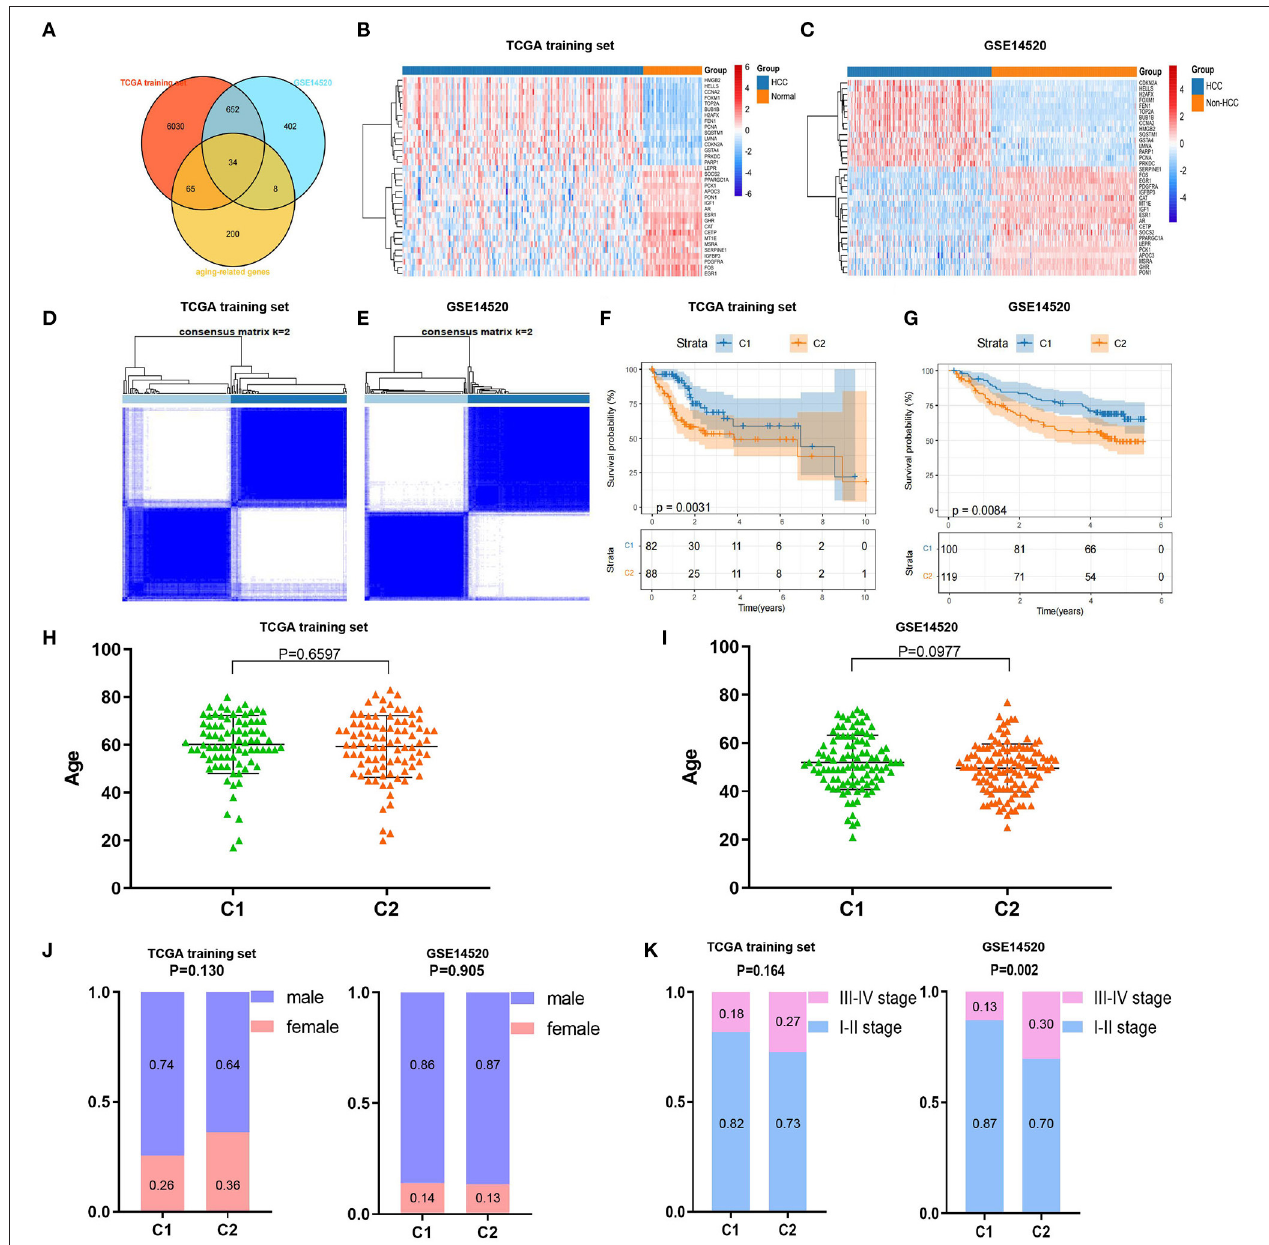
FIGURE 2 | Screening of differentially expressed aging-related genes (DEAGs), consistent clustering analysis, and comparison of molecular subtypes. (A) Venn diagram of DEGs from the The Cancer Genome Atlas (TCGA) training set, DEGs from GSE14520 and AGs. (B,C) Heatmaps of 34 DEAGs. (D,E) Cluster heatmaps of samples with consistent clusters of k = 2. (F,G) Kaplan–Meier (KM) curve analysis of overall survival between C1 and C2. (H,I) Comparison of age between C1 and C2. (J) Comparison of sex between C1 and C2. (K) Comparison of TNM stage between C1 and